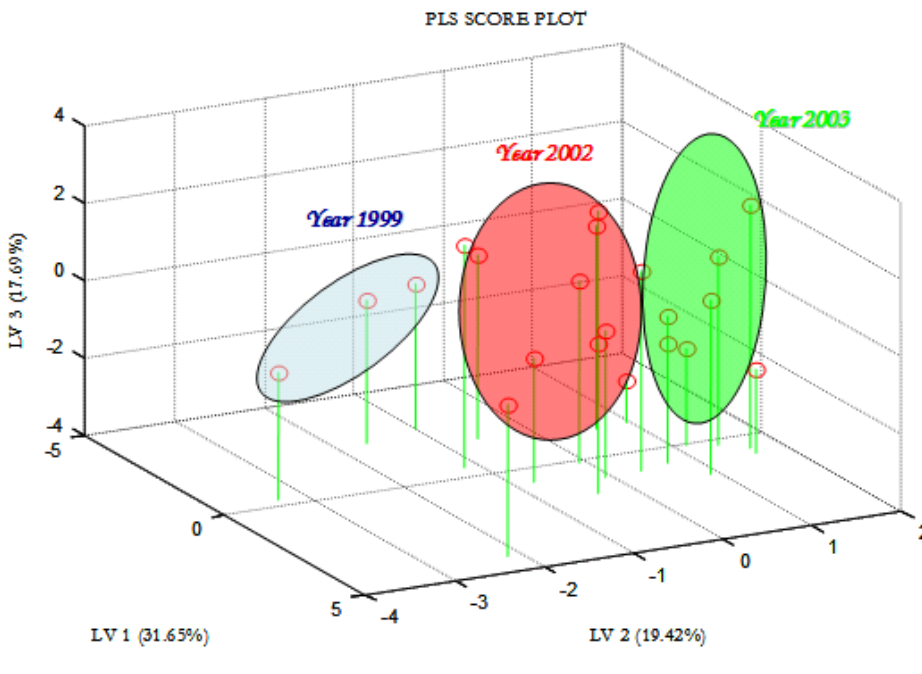
Figure 2. PLS-DA plot for ‘Verdicchio’ dry white wines: classification for year of